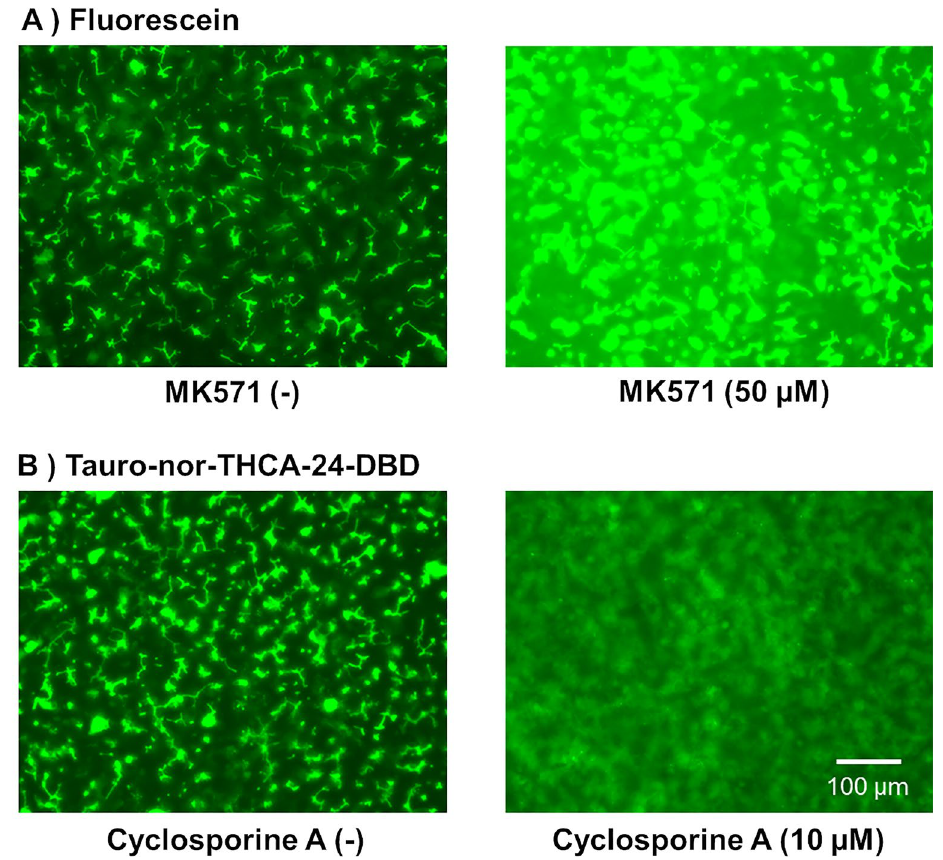
Figure 5. Effect of a biliary efflux transporter inhibitor on the excretion of the model substrate into bile canaliculi. Human-induced pluripotent stem cell-derived hepatocytes were cultured in a long-term maintenance medium for 28 days and then, they were sandwich-cultured in a maintenance medium for 9 days. After that, the effect of a biliary efflux transporter inhibitor on the excretion of the model substrate into bile canaliculi was examined. Fluorescence images show ( A ) Fluorescein or ( B ) Tauro-nor-THCA-24-DBD, when cells were treated with the biliary efflux transporter inhibitor (MK571 or cyclosporine A) or left